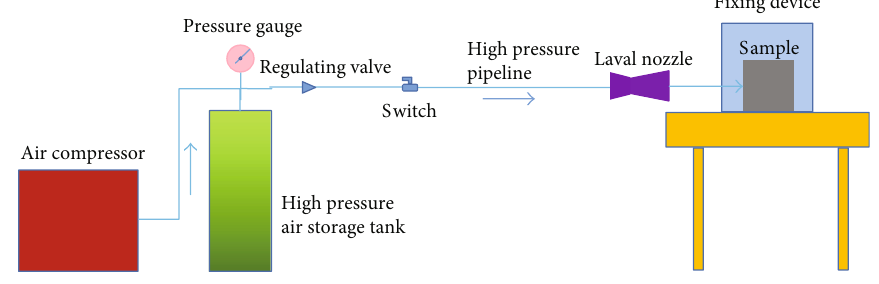
Figure 1: Schematic diagram of full impinging